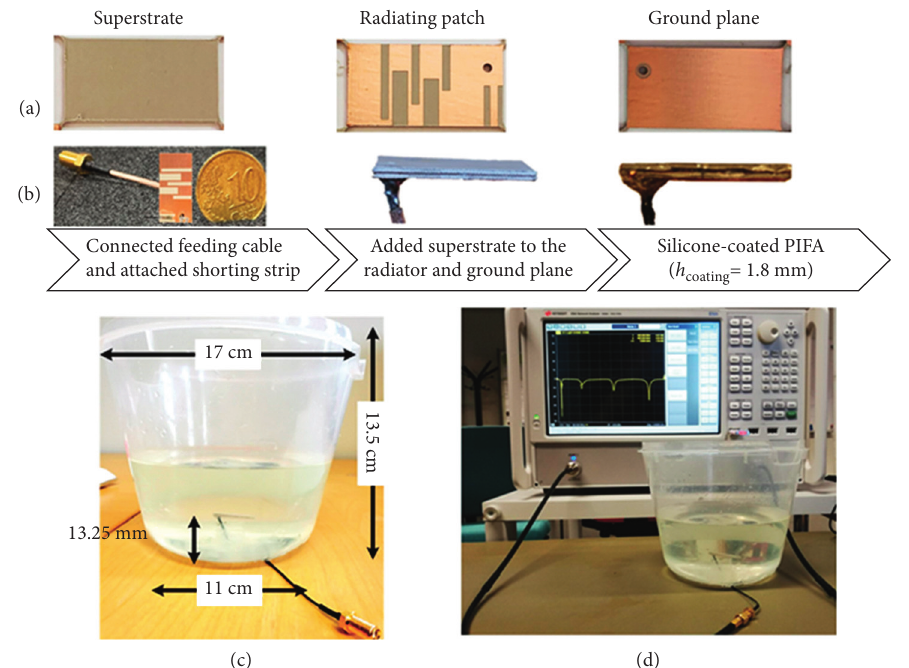
Figure 7: The prototyped PIFA. (a) Prototyped PIFA layers. (b) Assembled PIFA with feeding cable. (c) Phantom setup for testing of PIFA using a plastic truncated cone-shaped container. (d) Impedance matching measurement using VNA.